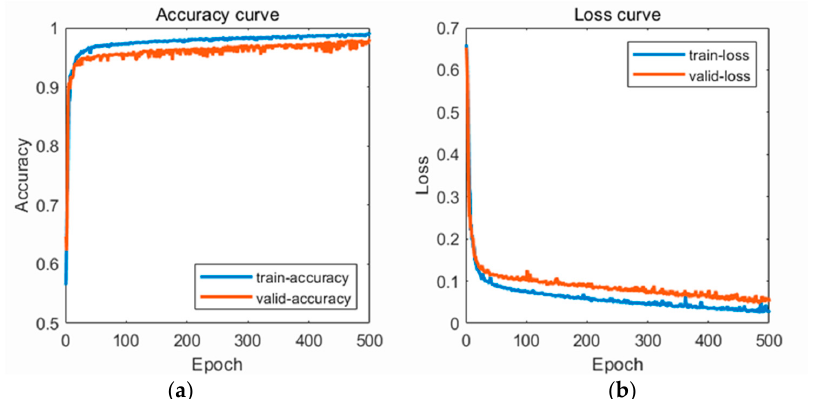
Figure 12. ( a ) Accuracy curve; ( b ) Loss curve.